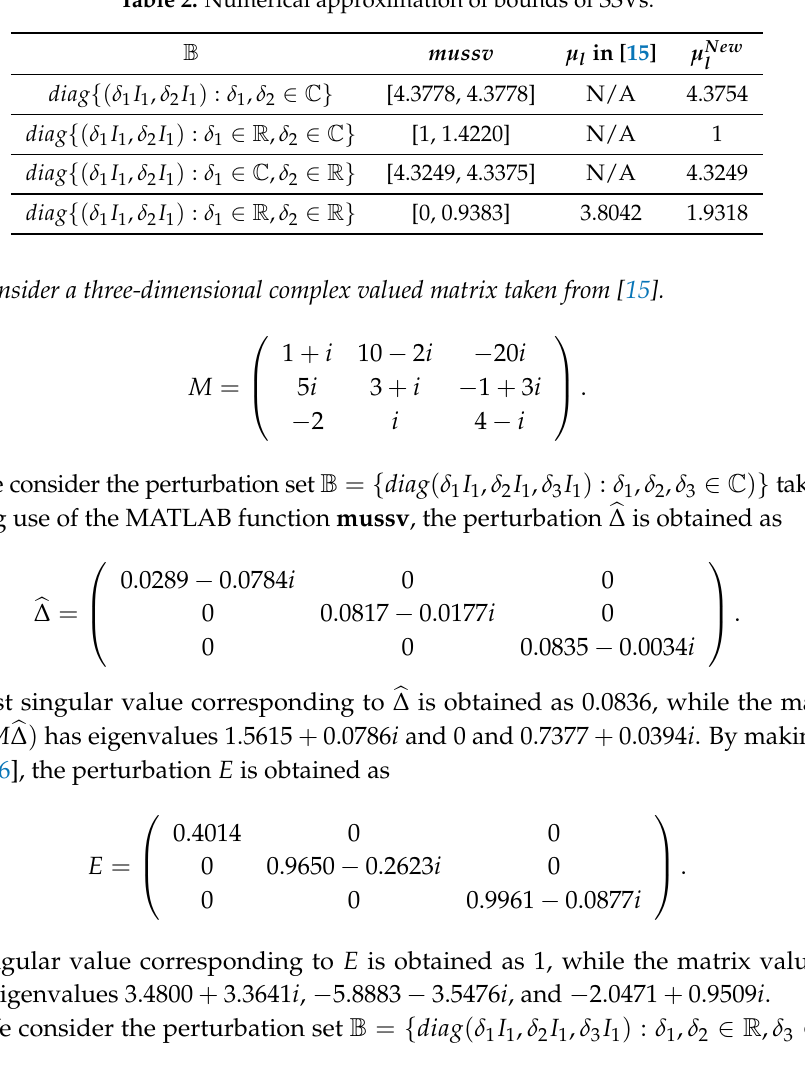
Table 2. Numerical approximation of bounds of